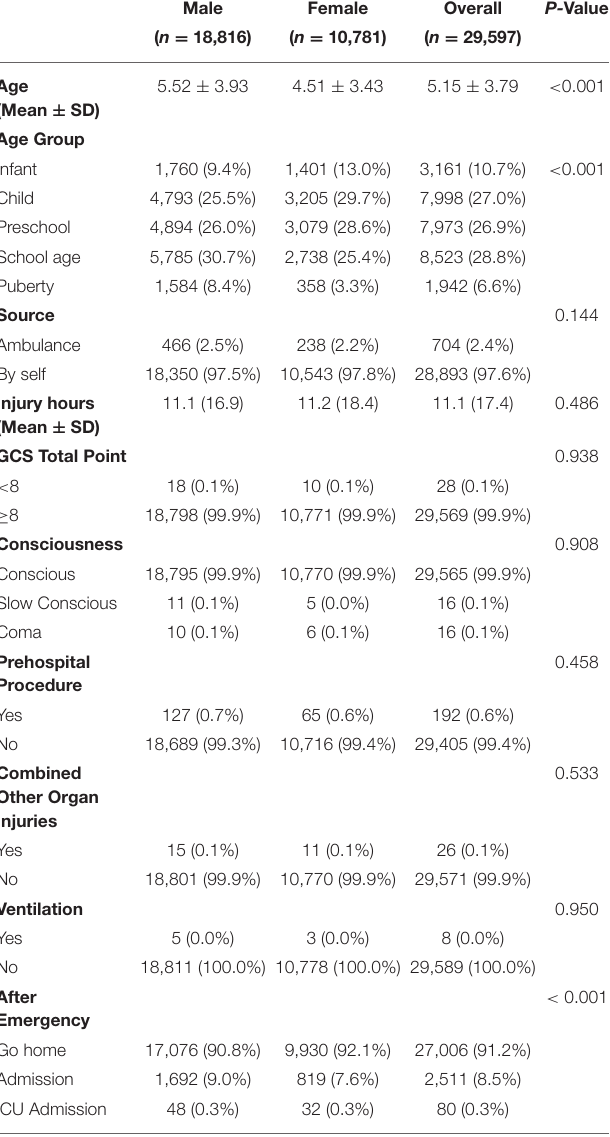
TABLE 1 | Characteristics of child unintentional injury patient in the emergency